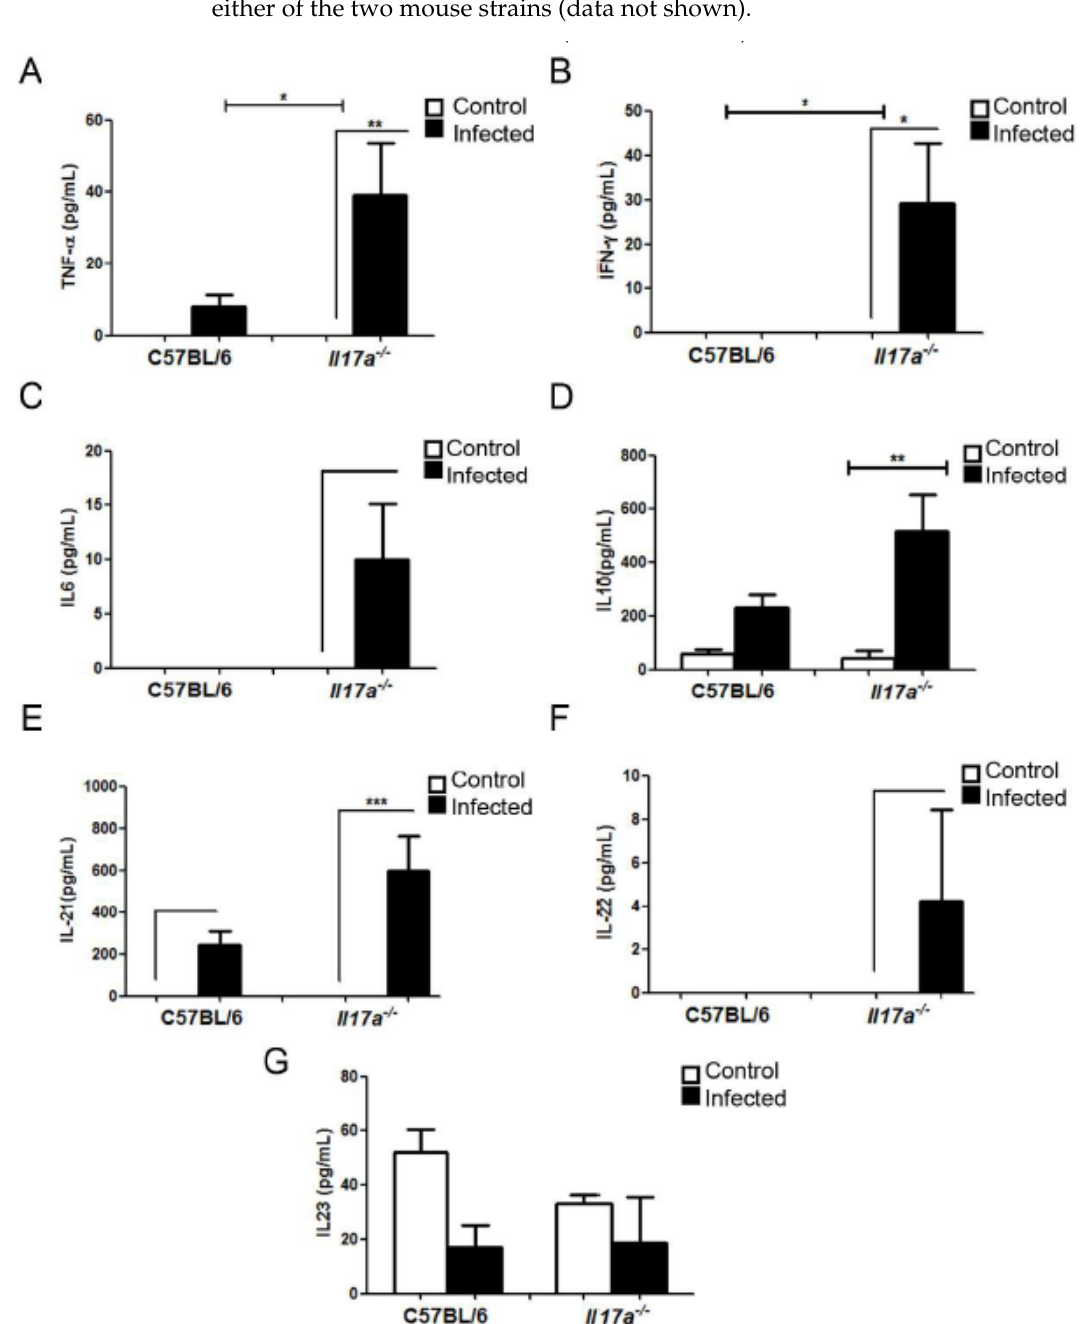
Figure 6. Cytokine concentration in brains of C57BL/6J and Il17a -/- mice. Mice were infected as indicated in Figure 7, and concentration of TNF- α ( A ), IFN- γ ( B ), IL-6 ( C ), IL-10 ( D ), IL-21 ( E ), IL-22 ( F ), and IL-23 ( G ) was determined from brain extracts after 9 days of infection. Figure represents mean and standard deviation of five different mice. Asterisks indicate significant difference between control and infected mice.